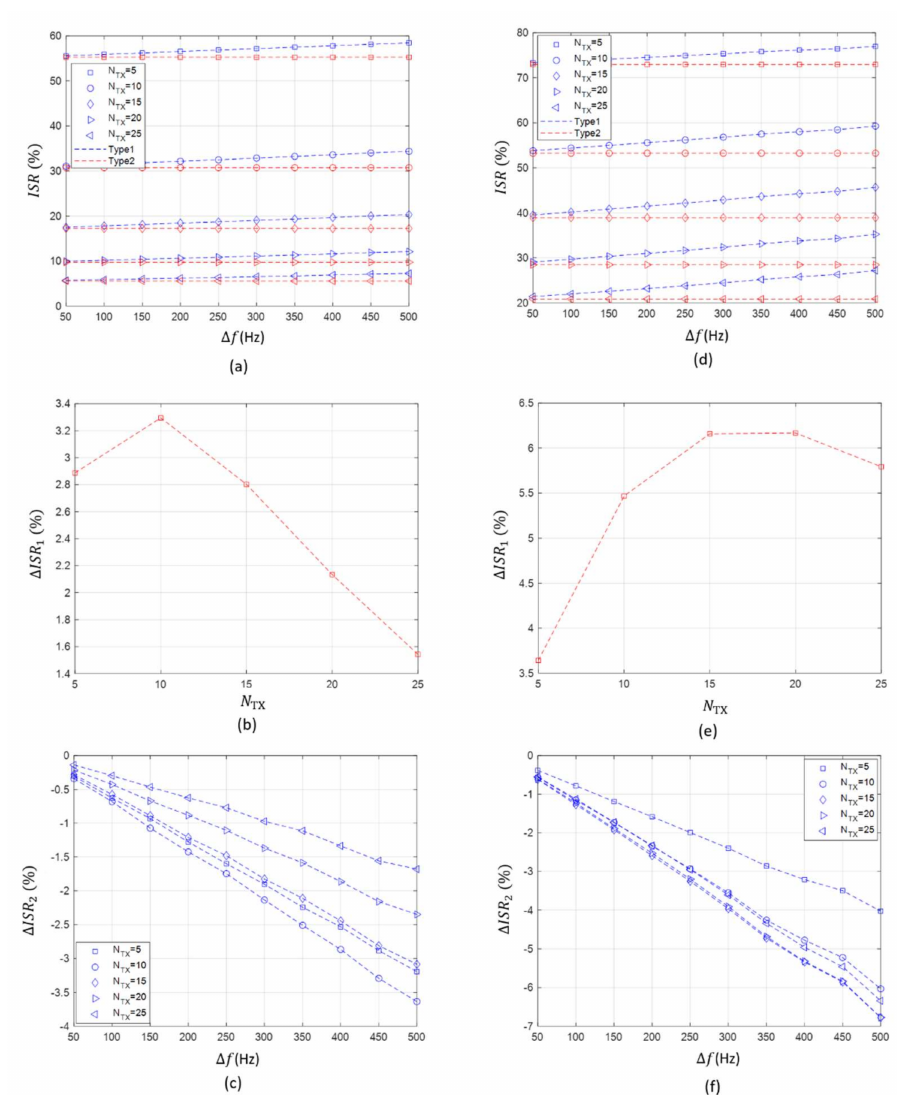
Figure 5. The ISR of Type 1 and Type 2 according to ∆ f , N TX , and B MAX . ( a ) ISR according to ∆ f , N = 10 kHz. ( b ) ∆ ISR = 10 kHz. ( c ) ∆ ISR = 10 kHz. ( d ) ISR 2 at B MAX TX at B MAX 1 at B MAX according to ∆ f , N TX at B MAX = 5 kHz. ( e ) ∆ ISR 1 at B MAX = 5 kHz. ( f ) ∆ ISR 2 at B MAX = 5